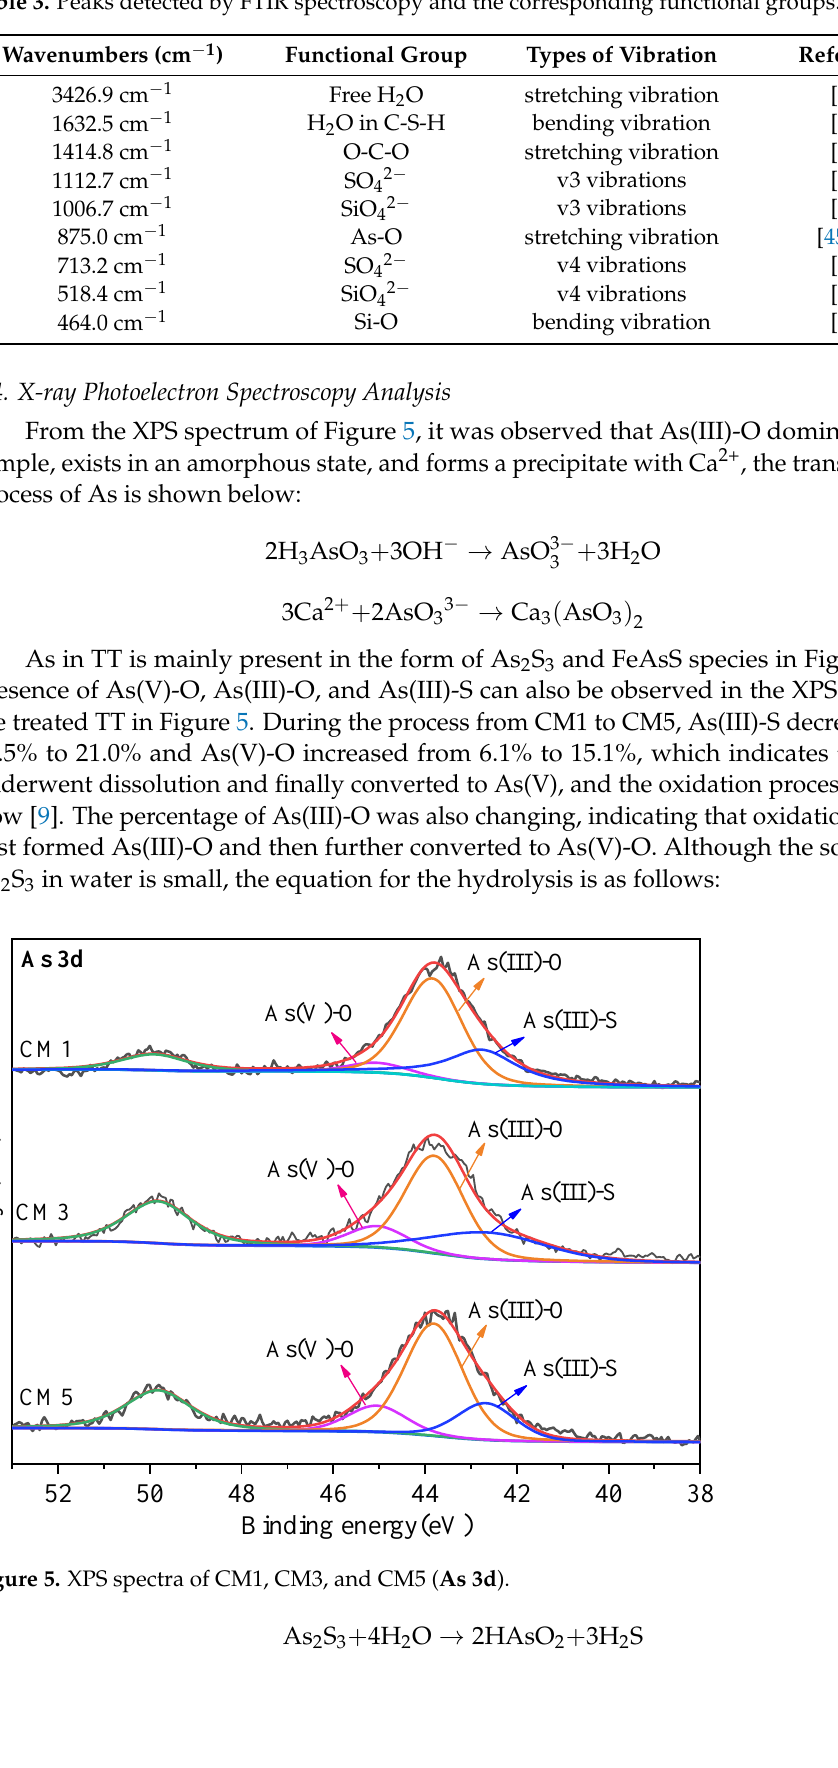
Table 3. Peaks detected by FTIR spectroscopy and the corresponding functional groups.